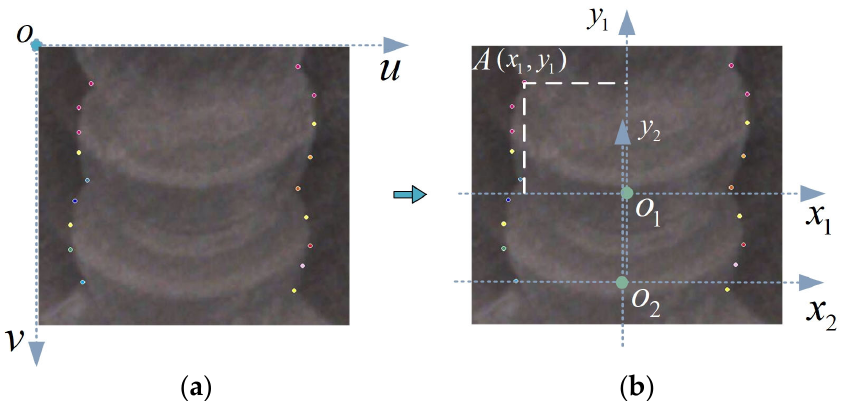
Figure 7. Diagram of coordinate system transformation: ( a ) image coordinate system; ( b ) weld coordinate system.